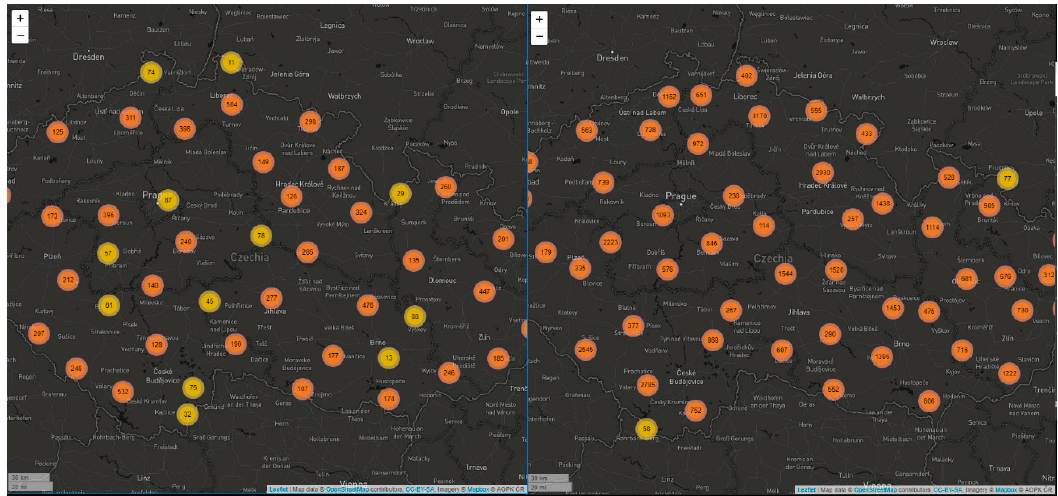
Figure 3. Map output of Leaflet.markercluster—testing on 10,000 and 50,000 of points. Testing shows that the solution provided by the Leaflet.markercluster plugin is the slowest one. The 10,000-point sample achieved a comparable time (1572 ms) with OpenLayers (1388 ms). However, from 50,000 points onwards, rendering time (11,612 ms) rapidly increased, and increased latency